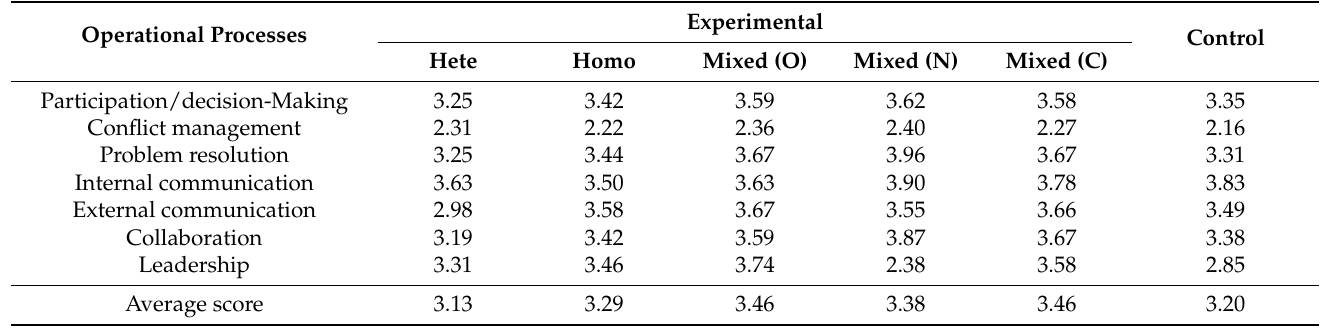
Table 10. Average scores of the experimentation groups by type of